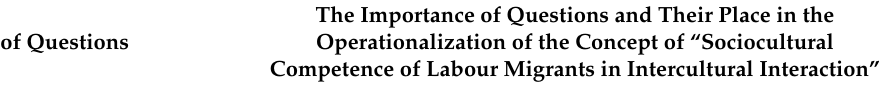
Table A1. Blocks of